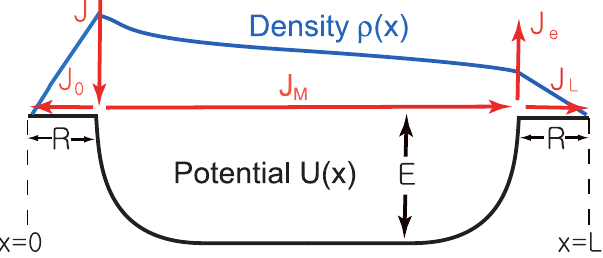
Figure 2. Transport through the NPC Is Modeled as Diffusion in an Energy Landscape The NPC channel is represented by a potential well U(x), shown in black. The complexes enter the NPC at x ¼ R at an average rate J. A fraction of the entrance flux, J M , goes through to the nucleus. The rest return to the cytoplasm at an average rate, J 0 . The exit of the complexes from the channel into the nucleus occurs either due to thermal activation, with the rate J L , or by activated release by RanGTP, with the rate J e . Steady state particle density inside the channel, q (x), is shown in blue. It differs from what would be expected from equilibrium statistical mechanics as the complexes do not accumulate at the minimum of the potential but rather their density decreases toward the